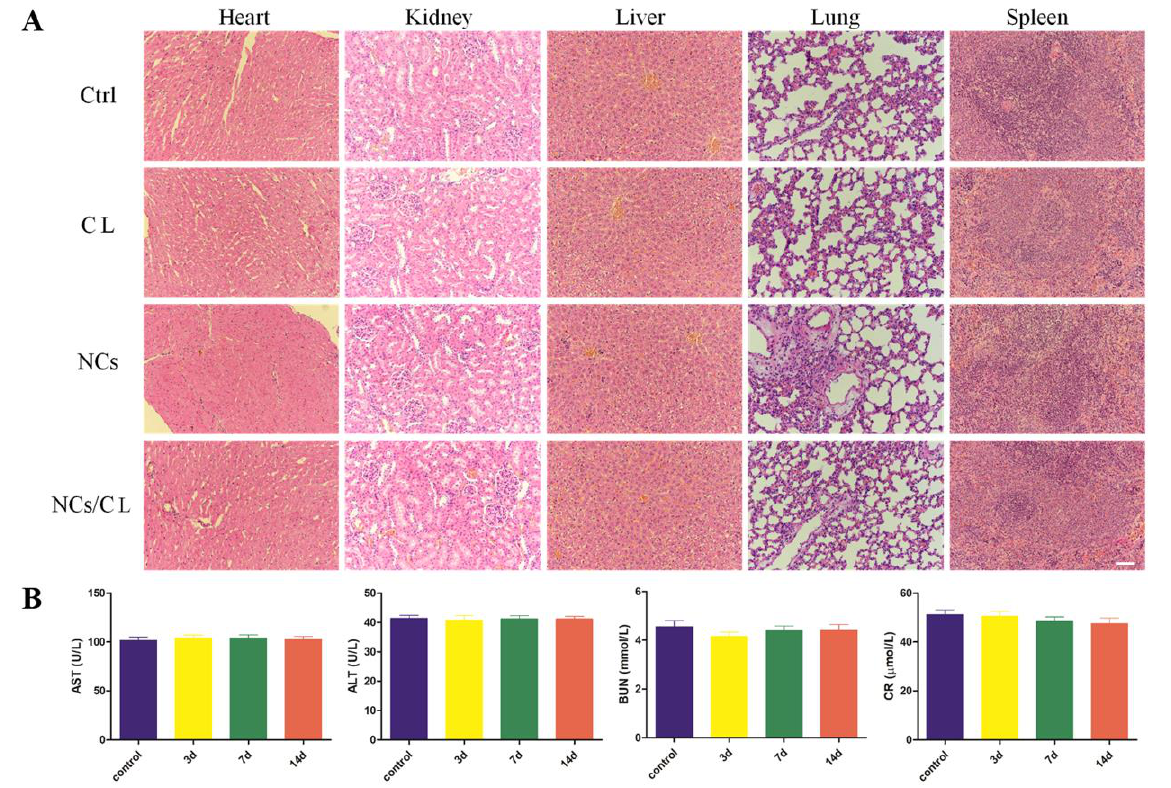
Figure 6. Biocompatibility of self-assembled CuCo 2 S 4 NCs/CL. ( A ) Representative images of HE staining of the heart, kidney, liver, lung, and spleen from ApoE −/− mice treated with PBS, CL, CuCo 2 S 4 NCs, and CuCo 2 S 4 NCs/CL followed by PTT. Scale bar = 100 μm. ( B ) Blood biochemical results of the mice from PBS as a control group and CuCo 2 S 4 NCs/CL group at different time-points (3 days, 7 days, 14 days) after injection, including AST, ALT, BUN, and CR.